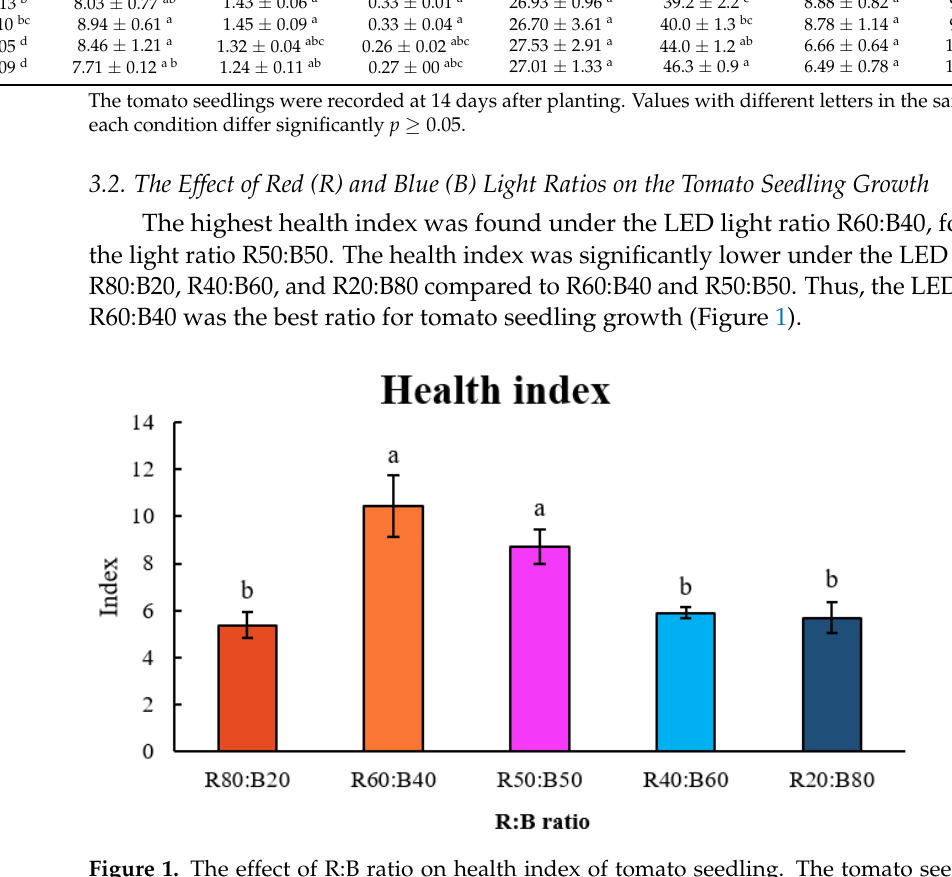
Table 2. Effect of different light intensities on tomato seedling growth.